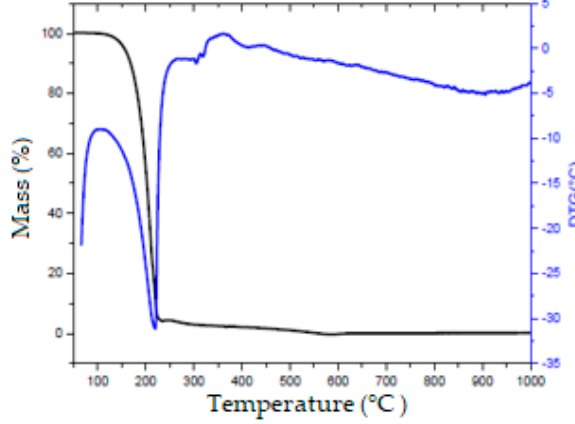
Figure 4. TGA / DTG profile of lauric acid. Figure 4. TGA/DTG profile of lauric acid.